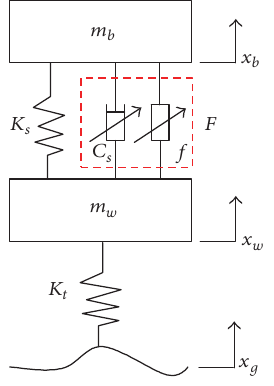
Figure 2: 2 DOF of the quarter-car